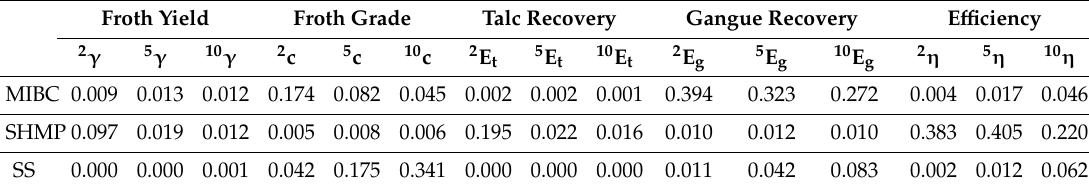
Table 4. Results of the analysis of variance (ANOVA) test ( p -values).